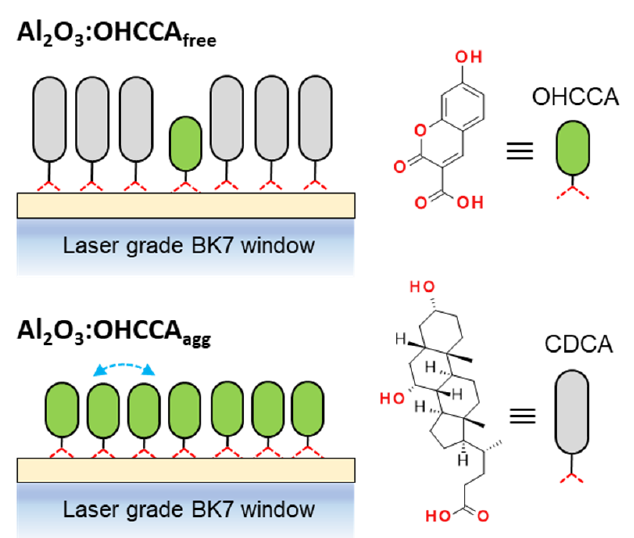
Scheme 1. Schematic structures of OHCCA adsorbed on Al 2 O 3 thin films with (top) and without (bottom) CDCA